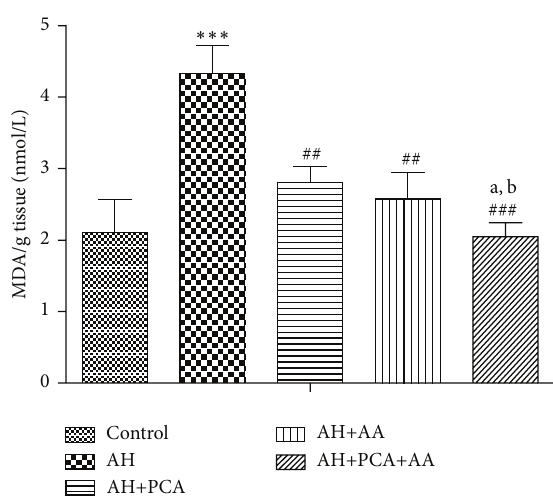
Figure 6: Effect of PCA alone and in combination with AA on lipid peroxidation in AH-treated rats. Values are expressed as mean ± SEM. Level of significance is considered as ∗ 𝑝 < 0.05 , ∗∗ 𝑝 < 0.01 , and ∗∗∗ 𝑝 < 0.001 compared to control group. # 𝑝 < 0.05 , ## 𝑝 < 0.01 , and ### 𝑝 < 0.001 compared to AH-treated group. a 𝑝 < 0.05 compared to AH+PCA and b 𝑝 < 0.05 compared to AH+AA group.